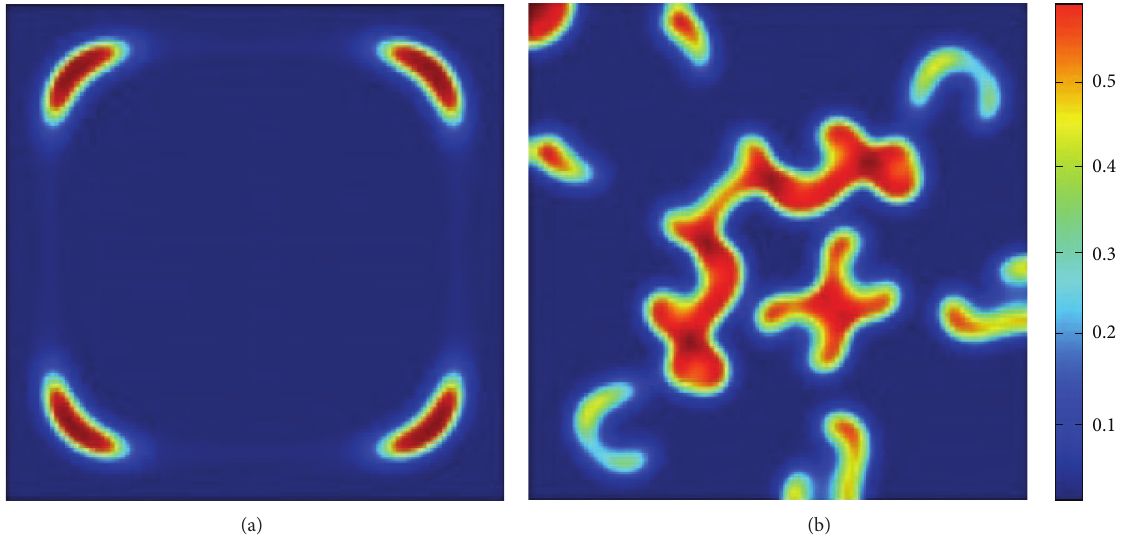
Figure 2: Snapshots of contour pictures of the vegetation at 𝑡 = 1000 with noise. Other parameters’ values are the same as in Figure 1(a). (a) 𝜀 = 0.001 and 𝜏 = 5 ; (b) 𝜀 = 0.1 and 𝜏 = 11